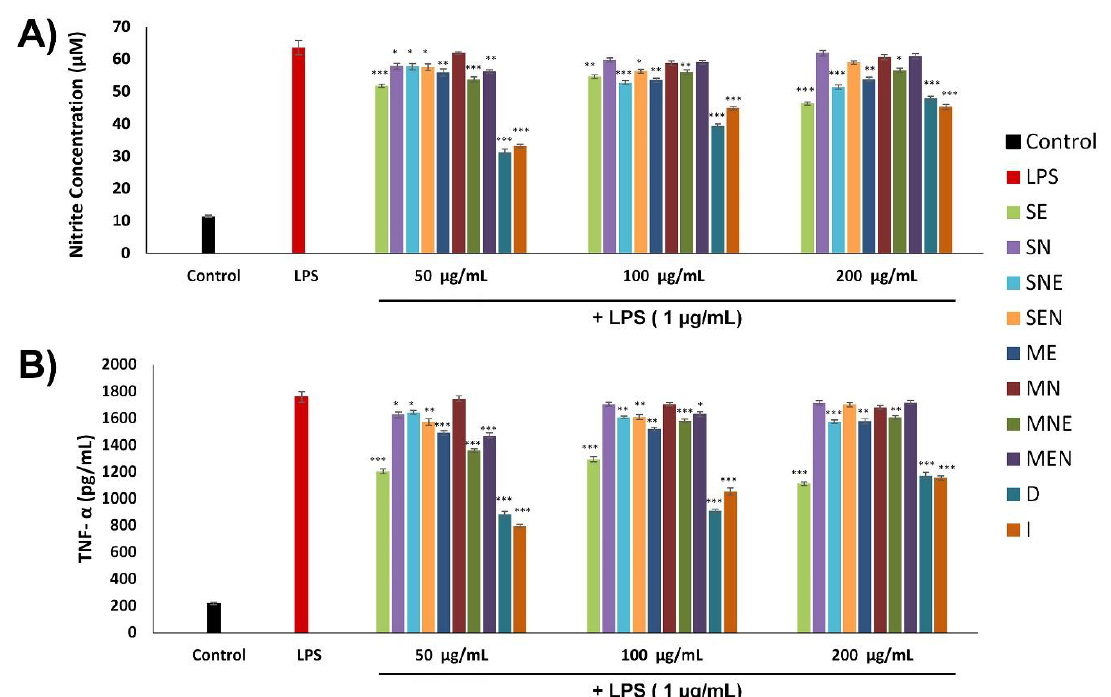
Figure 6. E ff ects of TS extracts on lipopolysaccharide (LPS)-induced nitric oxide (NO) ( A ) and Figure 6. Effects of TS extracts on lipopolysaccharide (LPS)-induced nitric oxide (NO) (A) and tumor tumor necrosis factor-alpha (TNF- α ) ( B ) production in macrophage cells. Untreated fibroblasts necrosis factor-alpha (TNF- α) (B) production in macrophage cells. Untreated fibroblasts were used as were used as control. Data were presented as mean ± SEM (n = 3) and compared with only control. Data were presented as mean ± SEM (n = 3) and compared with only LPS treated group, * p < LPS treated group, * p < 0.05, ** p < 0.01, *** p < 0.001. SE—Soxhlet ethanol, 0.05, ** p < 0.01, *** p < 0.001. SE — Soxhlet ethanol, SN — Soxhlet n-hexane, SNE — Soxhlet n-